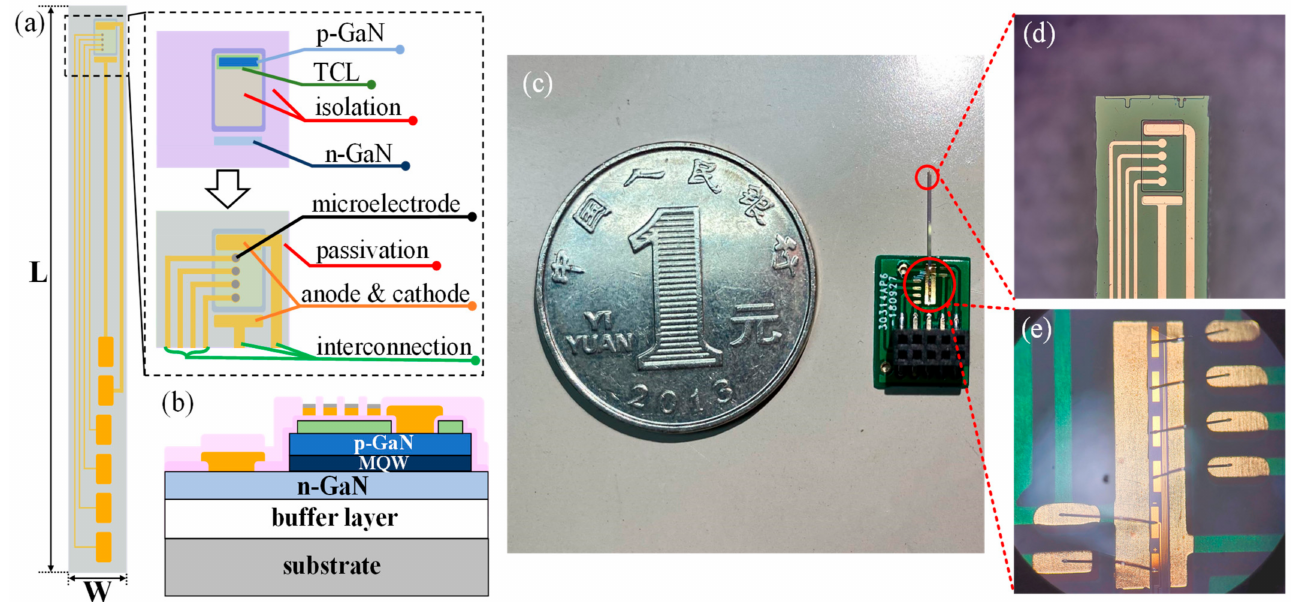
Figure 1. ( a ) Top view and ( b ) cross-sectional view of the monolithic integrated planar optrode. ( c ) The picture of the proposed encapsulated integrated planar optrode. ( d ) The micrograph of the top area and ( e ) the micrograph of the wire-bonded area on the